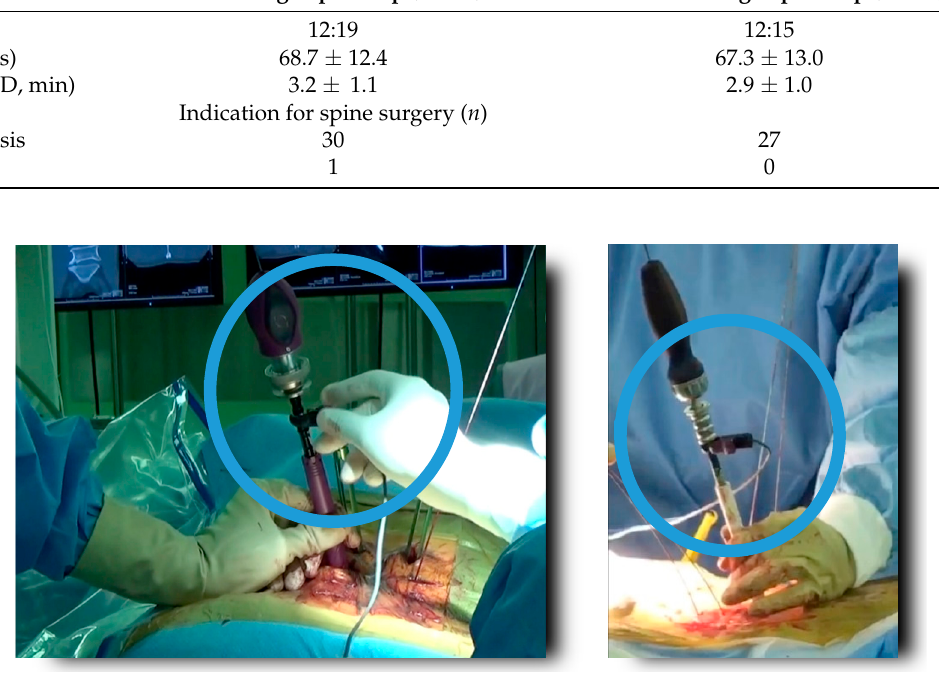
Figure 2. Before inserting the percutaneous pedicle screw, a TrEMG connecting clip was connected to the non-insulated part of the insulating tap and TrEMG was measured (NVM5 ® V2.0 Nerve Mon- itoring System: NuVasive, San Diego, CA, USA).